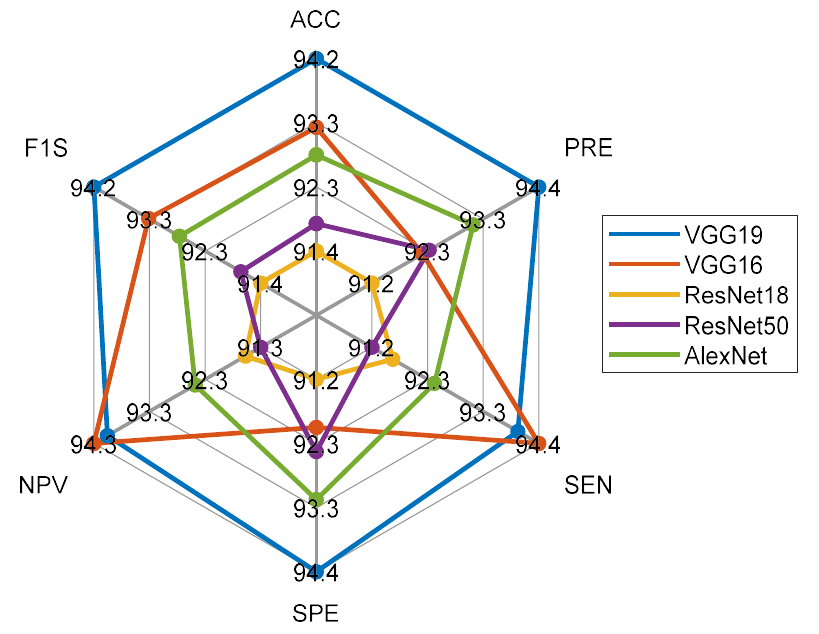
Figure 9. Spider plot to compare the CT image classification performance of CNN models. Table 4. Classification performance attained with pre-trained DL scheme with DF and SoftMax classifier. Here TP—true positives, FN—false negatives, TN—true negatives, FP—false positives, ACC—accuracy, PRE—precision, SEN—sensitivity,